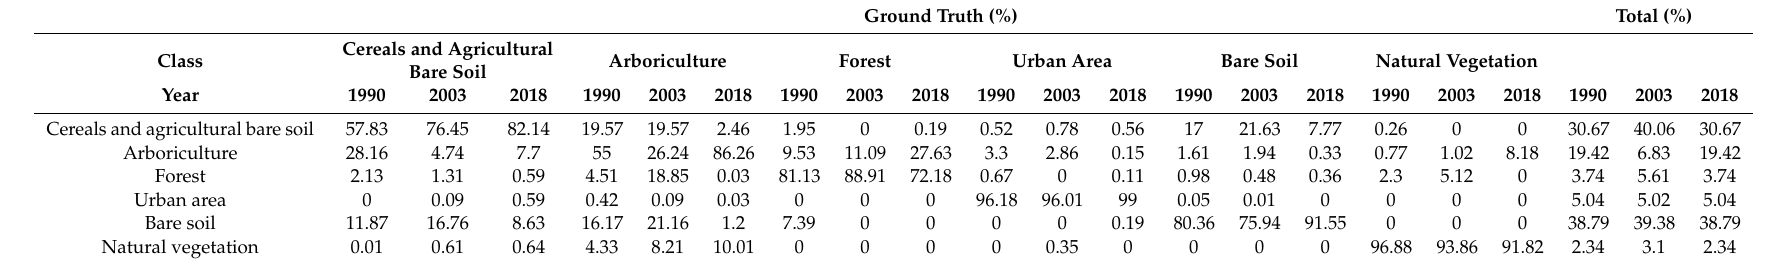
Table 2. Confusion matrix for the three times (1990, 2003 and